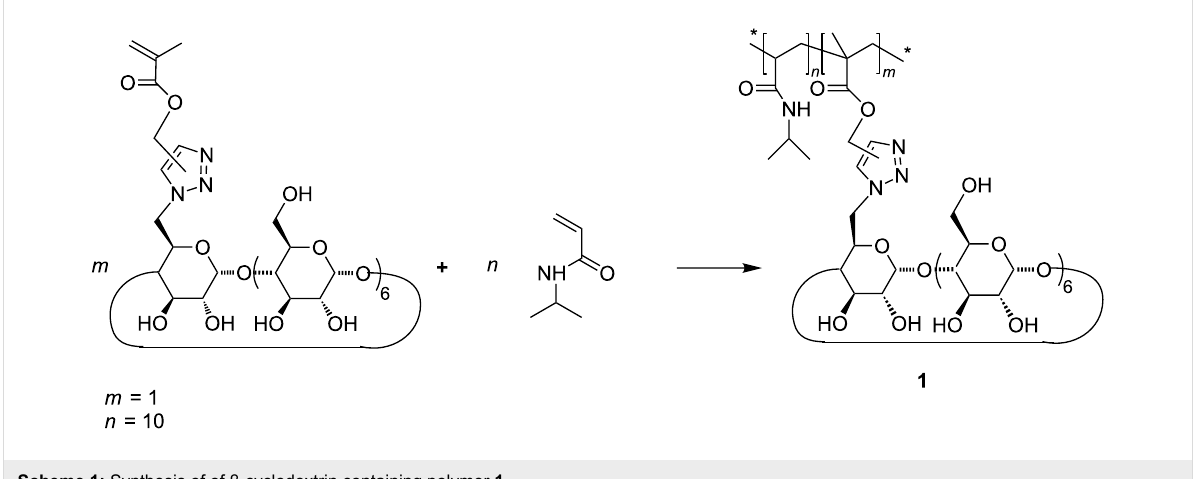
Scheme 1: Synthesis of of β -cyclodextrin containing polymer 1 .